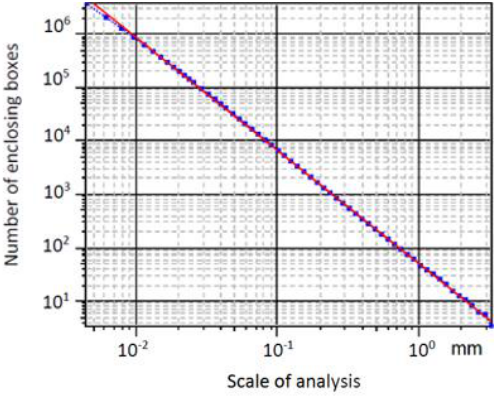
Figure 3. Fractal analysis plot for exemplary fracture surface.